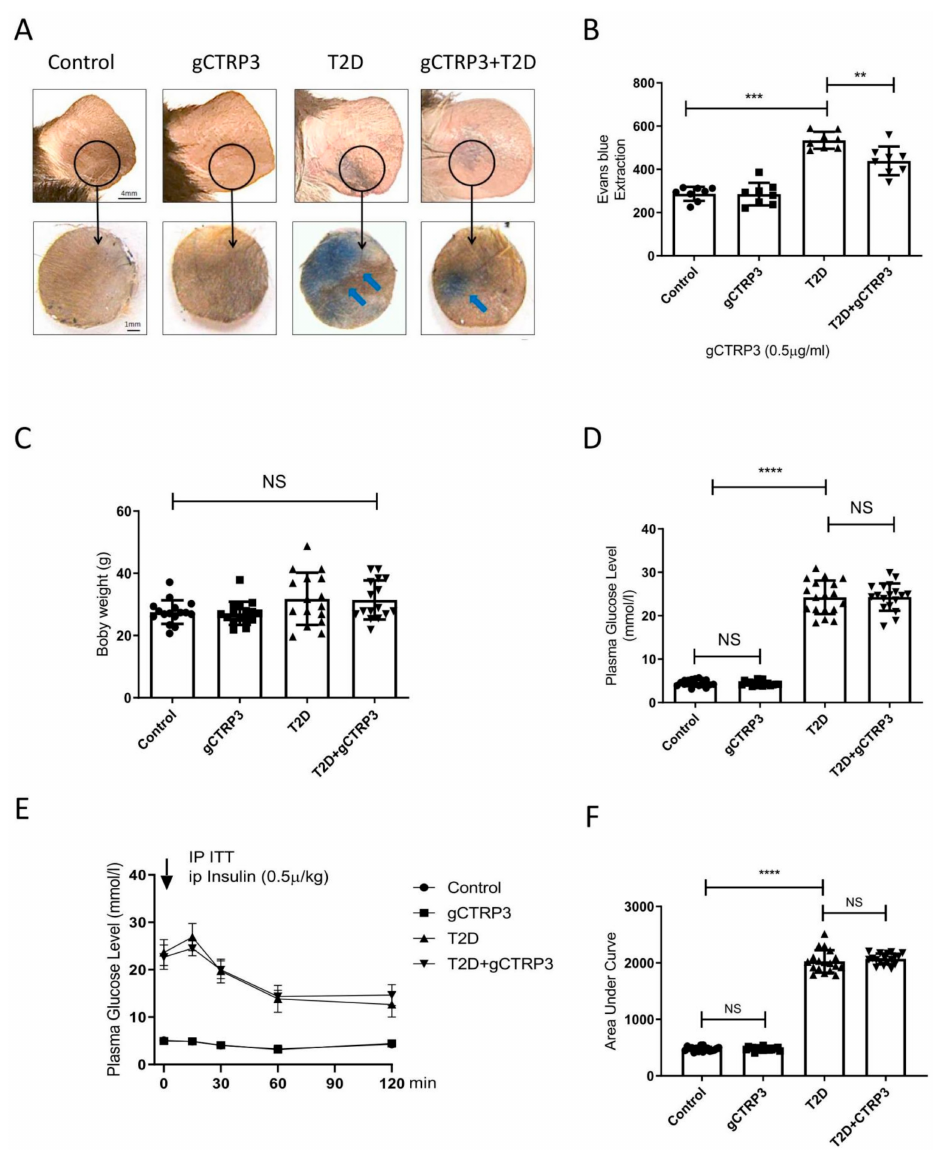
Figure 1. gCTRP3 ameliorated T2D-induced capillary leakage. ( A ), Representative images are showing that gCTRP3 (0.5 µ g/g/d) reduced Evans blue dye leakage to dermal adjacent tissue in T2D mice. ( B ), Quantification with column graph analysis ( n = 8–10). ( C ), gCTRP3 failed to affect body weight, blood glucose levels ( D ), or insulin resistance ( E , F ) in the diabetic retinopathy group when compared with Sham. All data are shown as means ± SD. n = 18 for each group. ** p < 0.01, *** p < 0.001, **** p < 0.0001; NS, no significance. Blue arrows indicate ear capillary leakage. HFD, high-fat diet. ND, normal